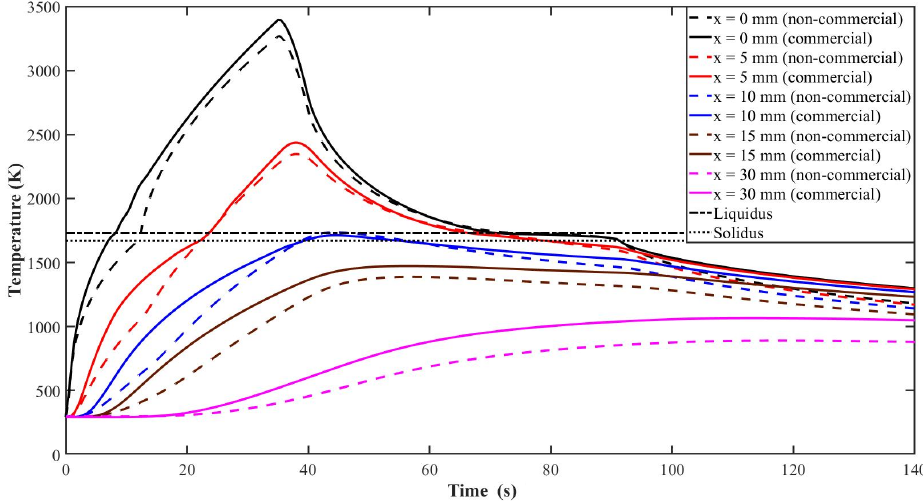
Figure 7. Comparison of thermal histories obtained by the non-commercial and commercial model.